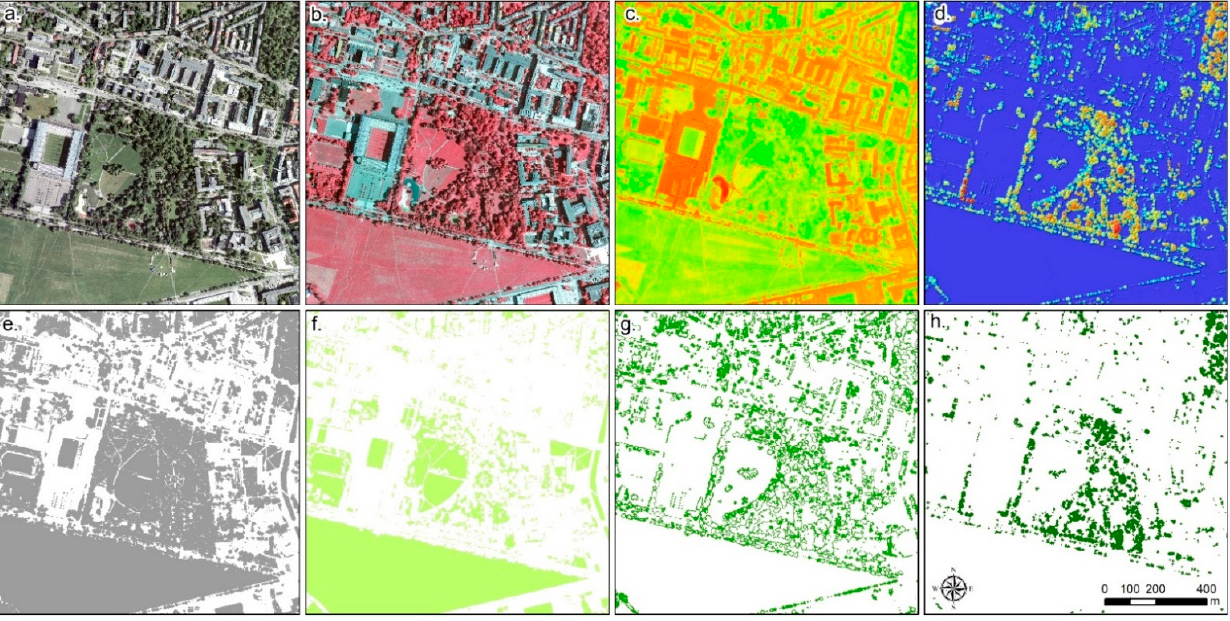
Figure 5. A detailed view of the part of Krakow in 2017 with different data sources and result layers of 2D/3D vegetation: ( a ) RGB aerial orthophoto; ( b ) CIR aerial orthophoto; ( c ) NDVI; ( d ) CHM; ( e ) 2D BAA mask of the urban “green” areas (grey pixels) and non-green (white pixels) areas; and 3D vegetation layers: ( f ) LV; ( g ) MV; ( h ) HV.